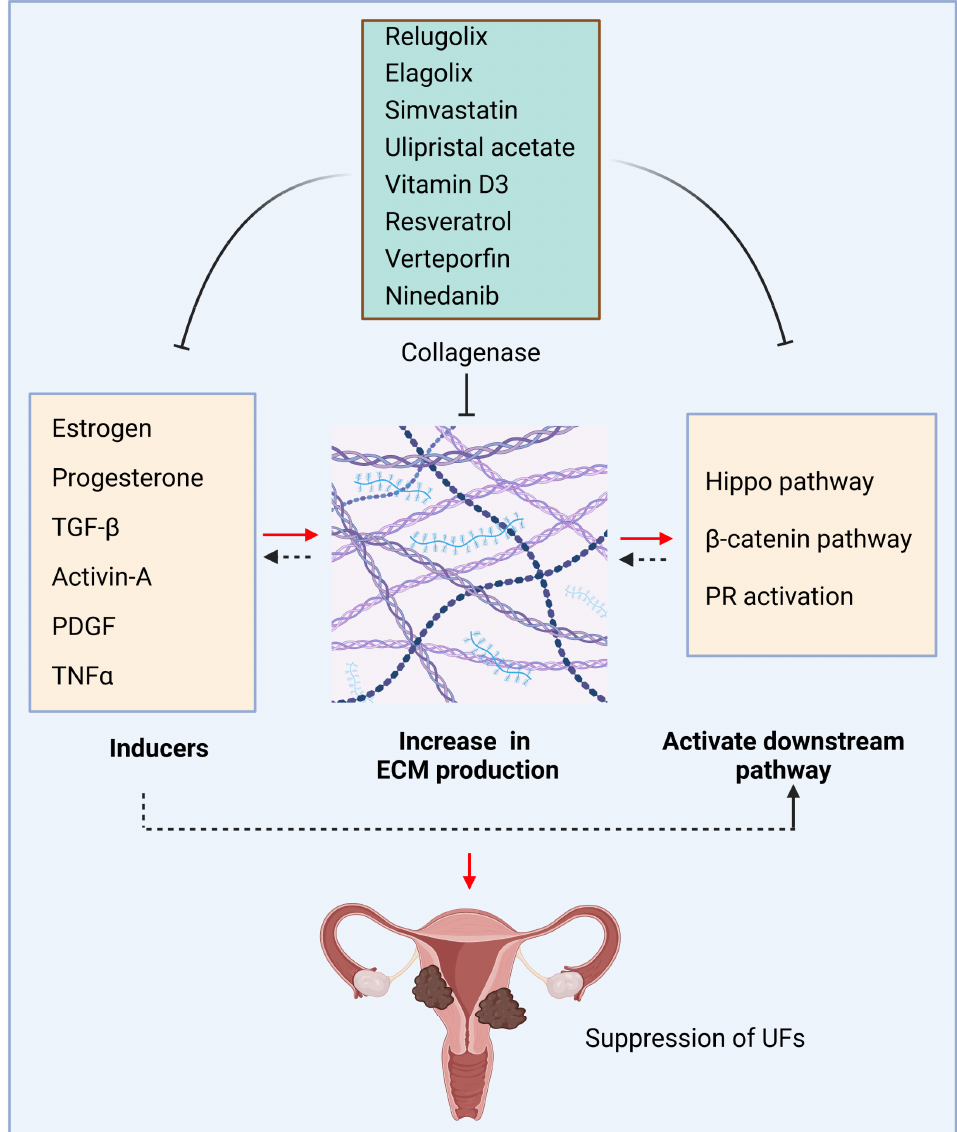
Figure 1. ECM production and inhibition in uterine fibroids. ECM inducers, including hormones, cytokines, and growth factors, trigger the deposition and accumulation of ECM, activating downstream pathways and creating a pathological loop to promote the pathogenesis of UFs. Conversely, targeted inhibition of ECM inducers and relevant pathways decreases the production of ECM, concomitantly with the changes in mechanotransduction and relevant signaling, which contribute to the develop- ment and progression of UFs. Black dotted arrow: need further investigation; This figure was created using BioRender software. PR: progesterone